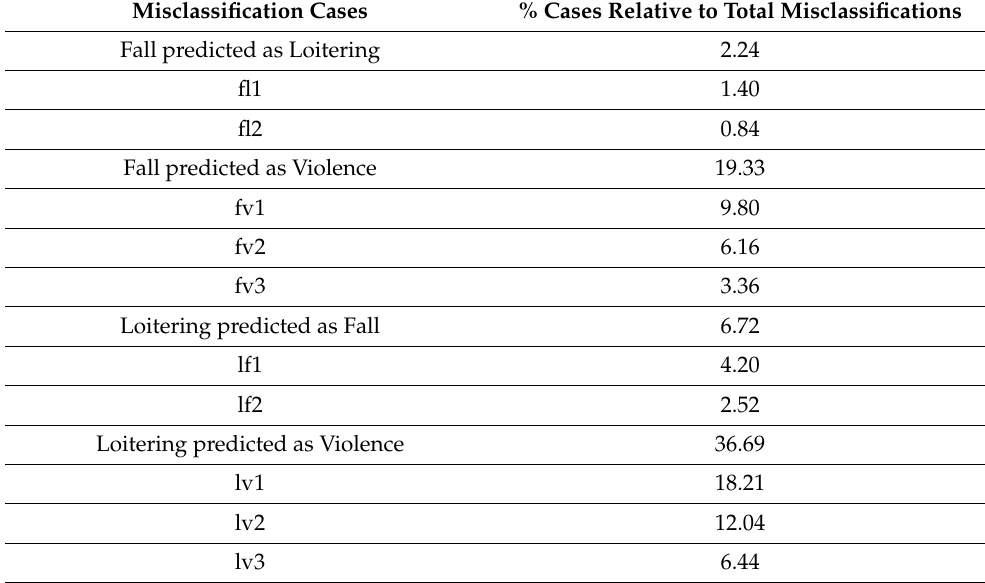
Table 4. Percentage of different cases of